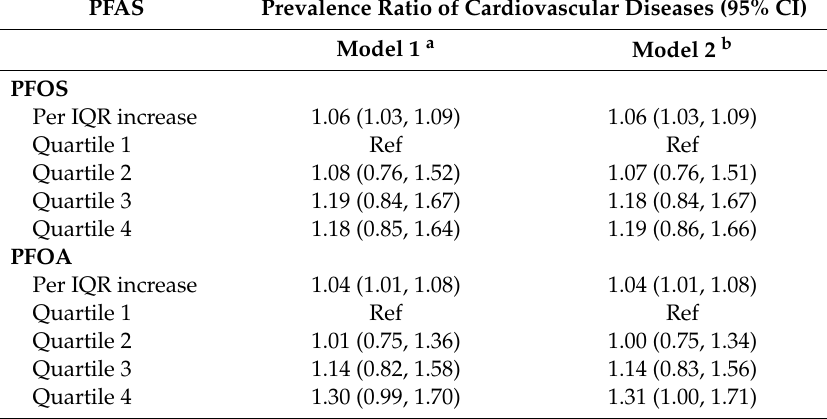
Table 3. Associations between serum PFAS levels (ng / mL) and cardiovascular diseases in models with or without adjustment of body mass index (BMI; n =